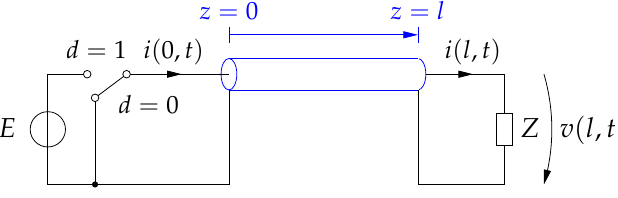
Figure 2. Distributed buck converter with a transmission